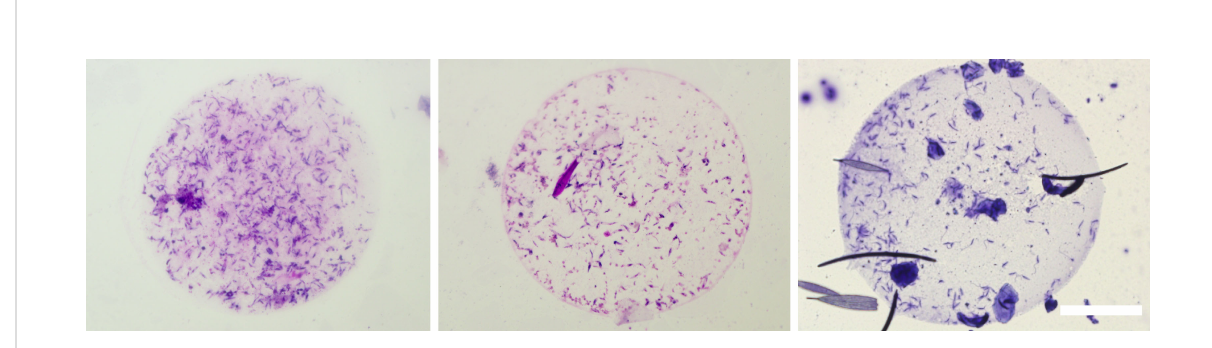
FIGURE 7 Porcisia deanei promastigotes in urine droplets of Lutzomyia longipalpis . Scale bar indicates 100